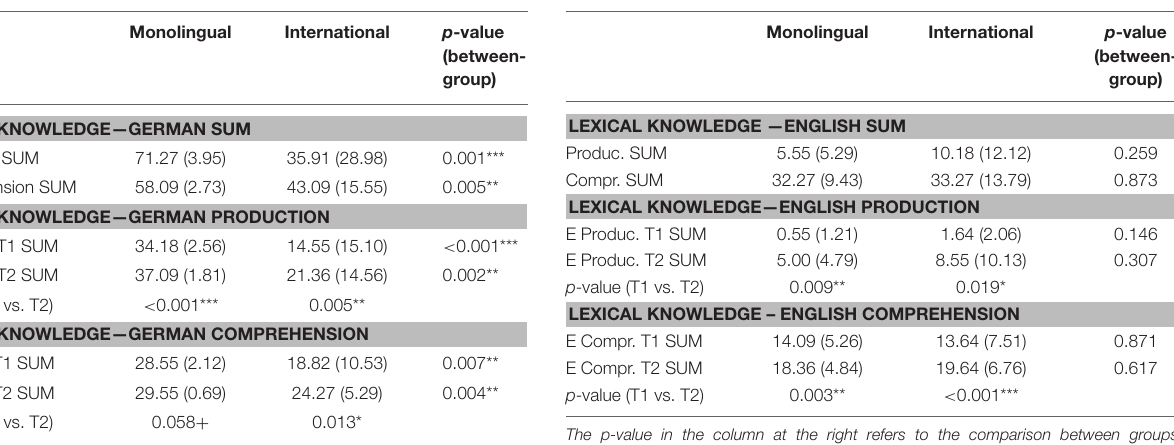
TABLE 2 | Means and standard deviations in parentheses for lexical knowledge of groups per skill for